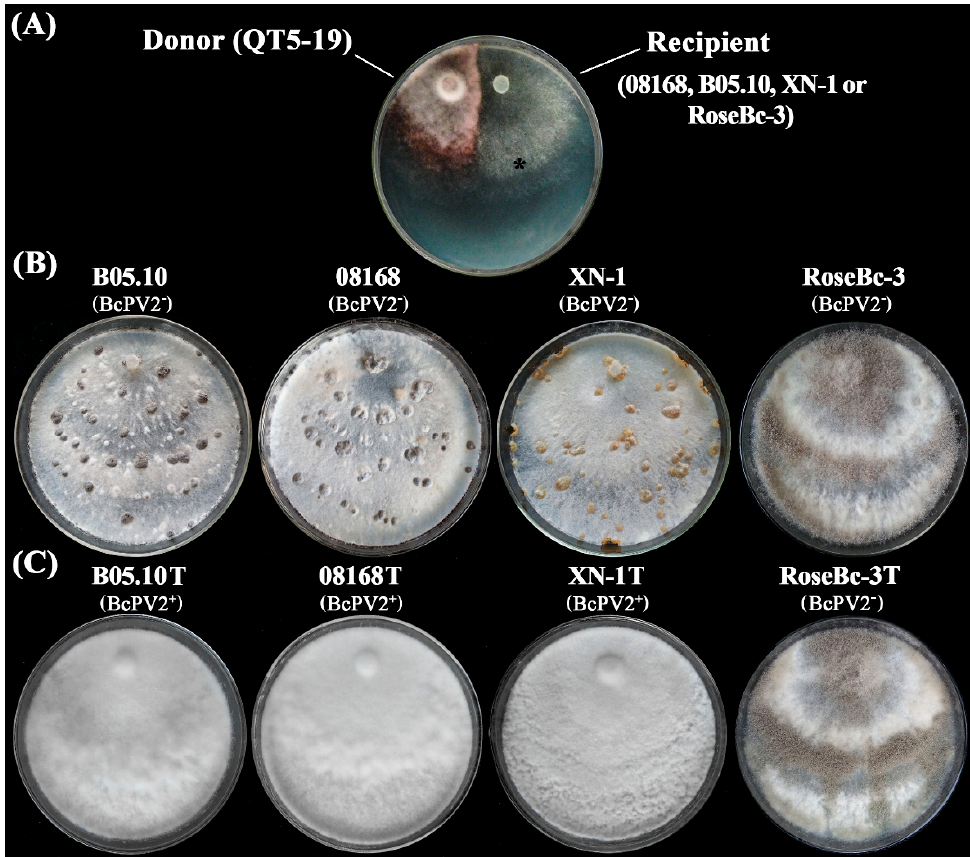
Figure 8. Horizontal transmission of BcPV2 through hyphal contact in pair cultures on PDA. ( A ) A pair culture on PDA with the colonies of isolate QT5-19 (BcPV2 donor, pink color) and a recipient (gray color). The symbol (*) in the colony indicated the area where a mycelial agar plug was removed and transferred to PDA for establishing a BcPV2-transmitted derivative; ( B ) Four PDA cultures (20 °C, 20 day) of the B. cinerea isolates free of infection by BcPV2 (BcPV2 − ); ( C ) Four PDA cultures (20 °C, 20 day) of the transfected derivatives of B. cinerea . BcPV2 + , infected by BcPV2, BcPV2 − , not infected by BcPV2.